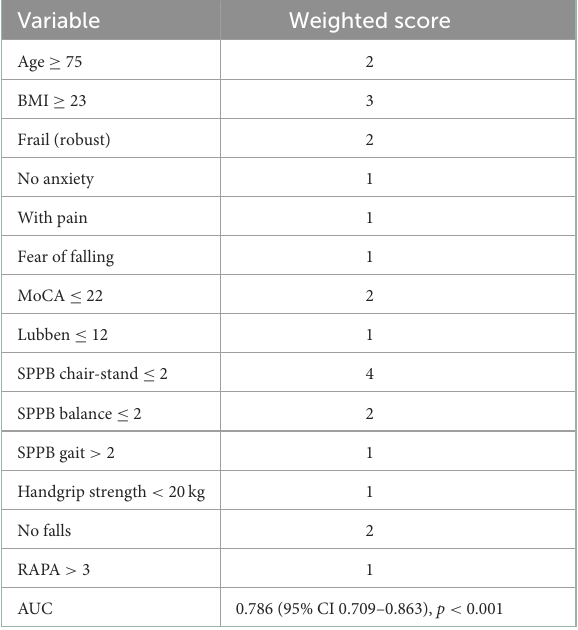
(Table 5). On the other hand, participants with a score of 17